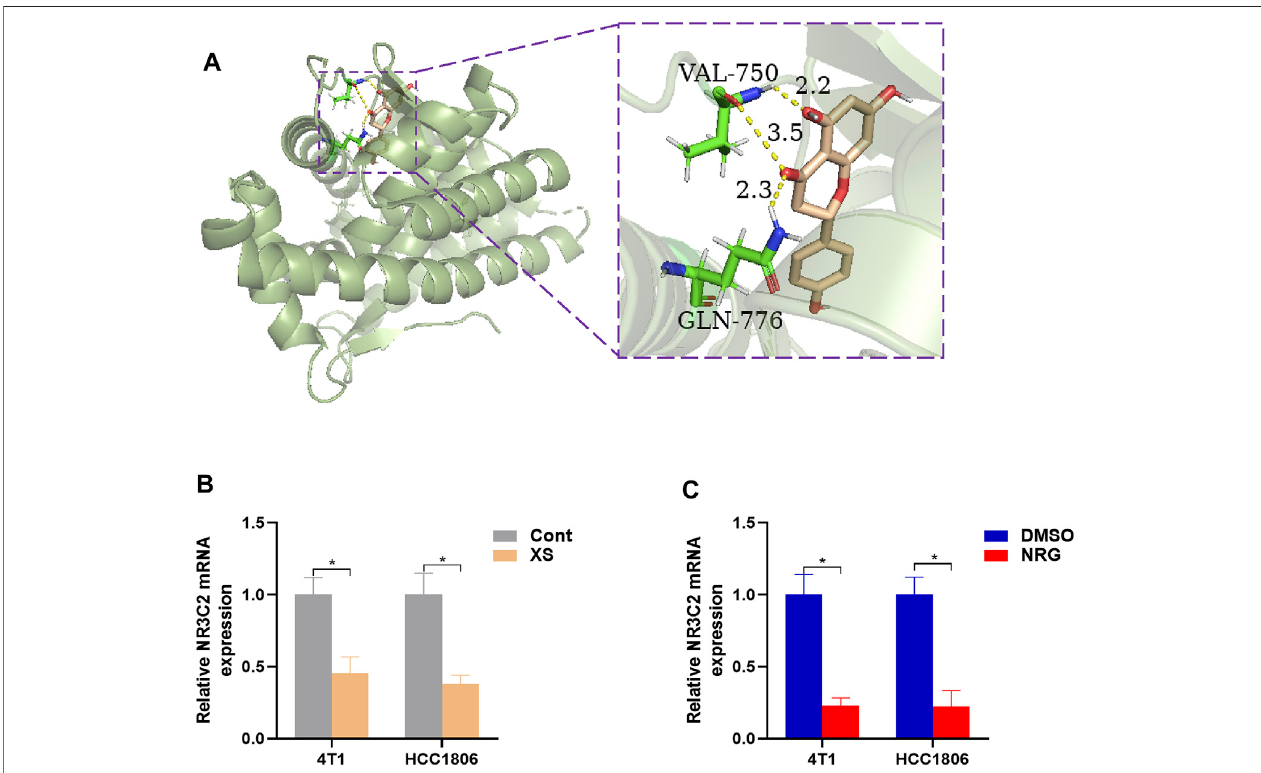
FIGURE 6 | (A) The result of molecular docking of NR2C3 with naringenin. The smudge is target protein and mineralocorticoid receptor, and the target gene is NR3C2. Wheat: active compound, naringenin; green: binding sites; dotted yellow lines: bonds. The af fi nity value is − 9.7 Kcal/mol. (B,C) RT-PCR outcomes, presented levelsofNR3C2afterXStreatmentcomparedtocontrolserum(Cont)and50 nMNRGtreatmentcomparedtocontrol(DMSO).* p < 0.05,** p <